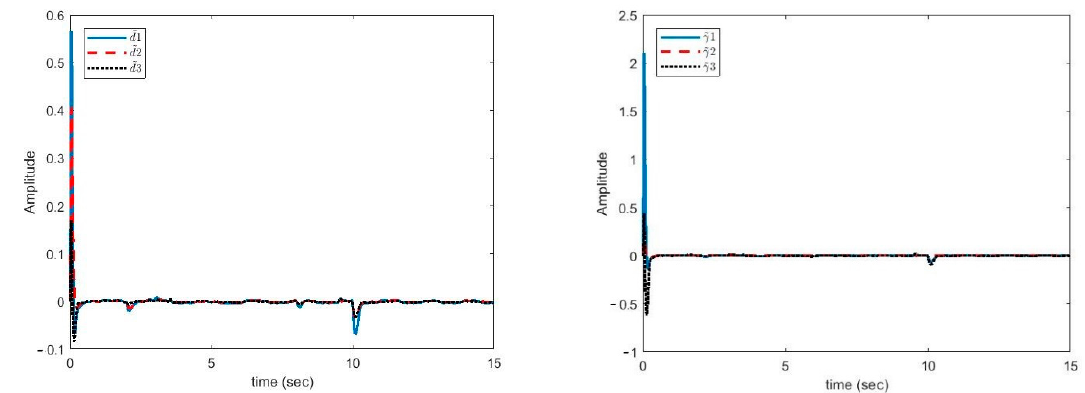
Figure 5. Estimation error of disturbance bounds (left). Estimation error of uncertainties bounds versus time (right).